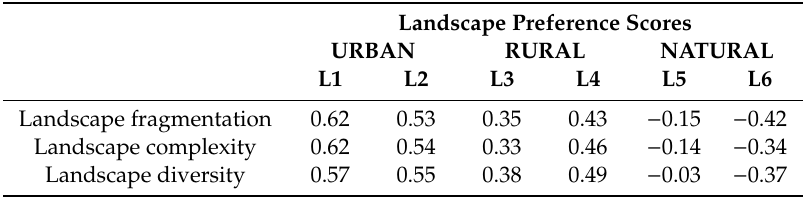
Table 4. Mean preference scores and normalized landscape metrics of the six landscape types investigated in relation to three di ff erent levels of TOF